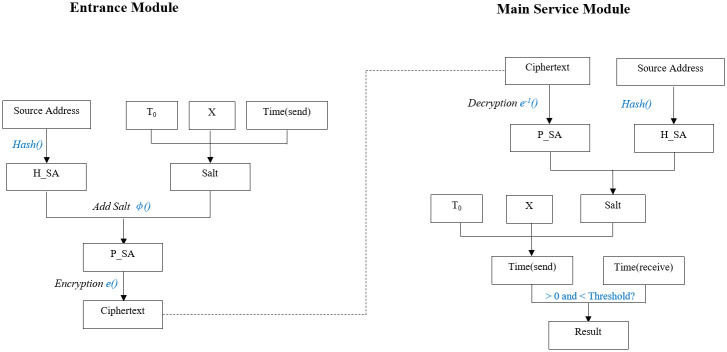
Salting process.